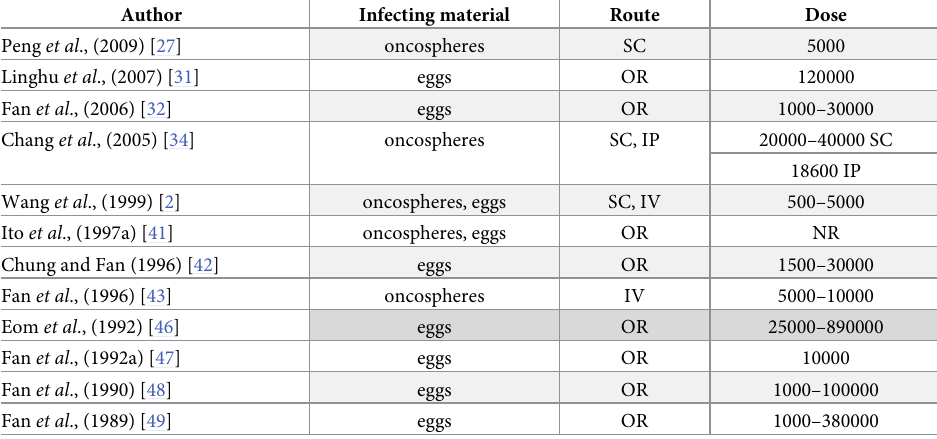
Table 7. Description of the infecting material, dose and route such as subcutaneous (SC); oral (OR); intraperito- neal (IP) and intravenous (IV) used in the studies for T . s asiatica .